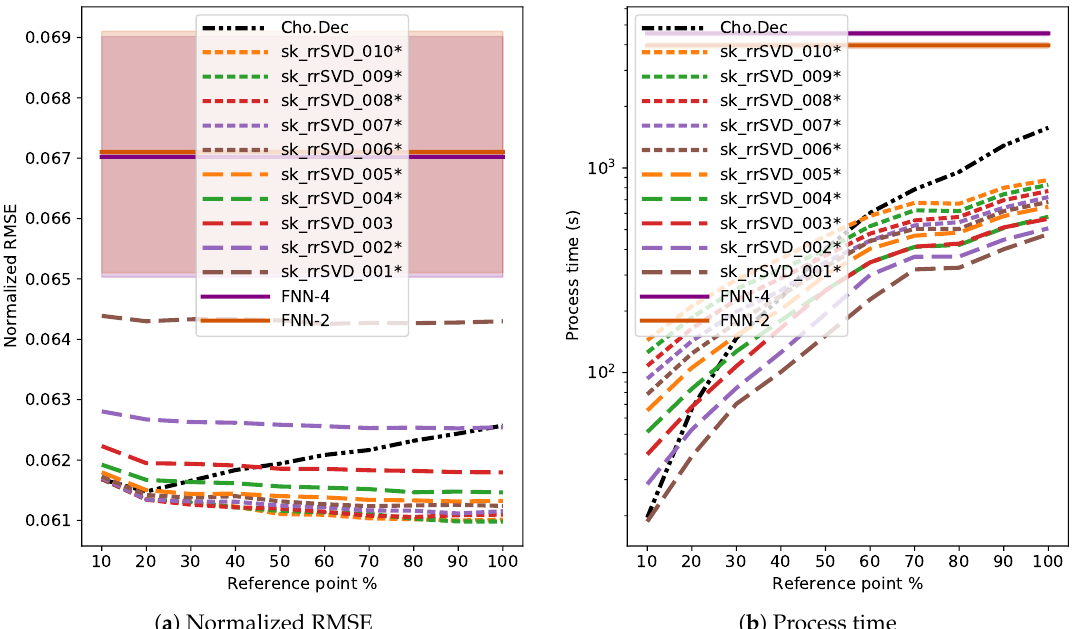
Figure A5. Normalized RMSE values ( a ) and process time in seconds taken to compute Equation (1) ( b ) as a function of reference point percentage for the Census dataset. For MLM, variants of sk_rrSVD_XX that differ statistically from Cholesky decomposition are marked with *.